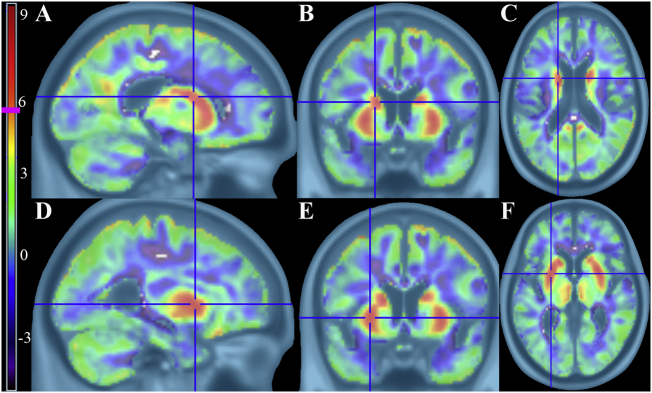
Controls > iNPH t-maps using PVC corrected FDG-PET images showing significant hypometabolism in iNPH patients. The volume averaging confound is no longer present, but the subcortical hypometabolism is clearly evident. Vertical t-score bar on the left with pink line at significance height threshold of 5.57 ((p < 0.05, FWE corrected, k = 40) A–C) Left body of caudate in sagittal, coronal, and axial views (peak t-score 8.01) D–F) Left putamen in sagittal, coronal, and axial views (peak t-score 7.42).